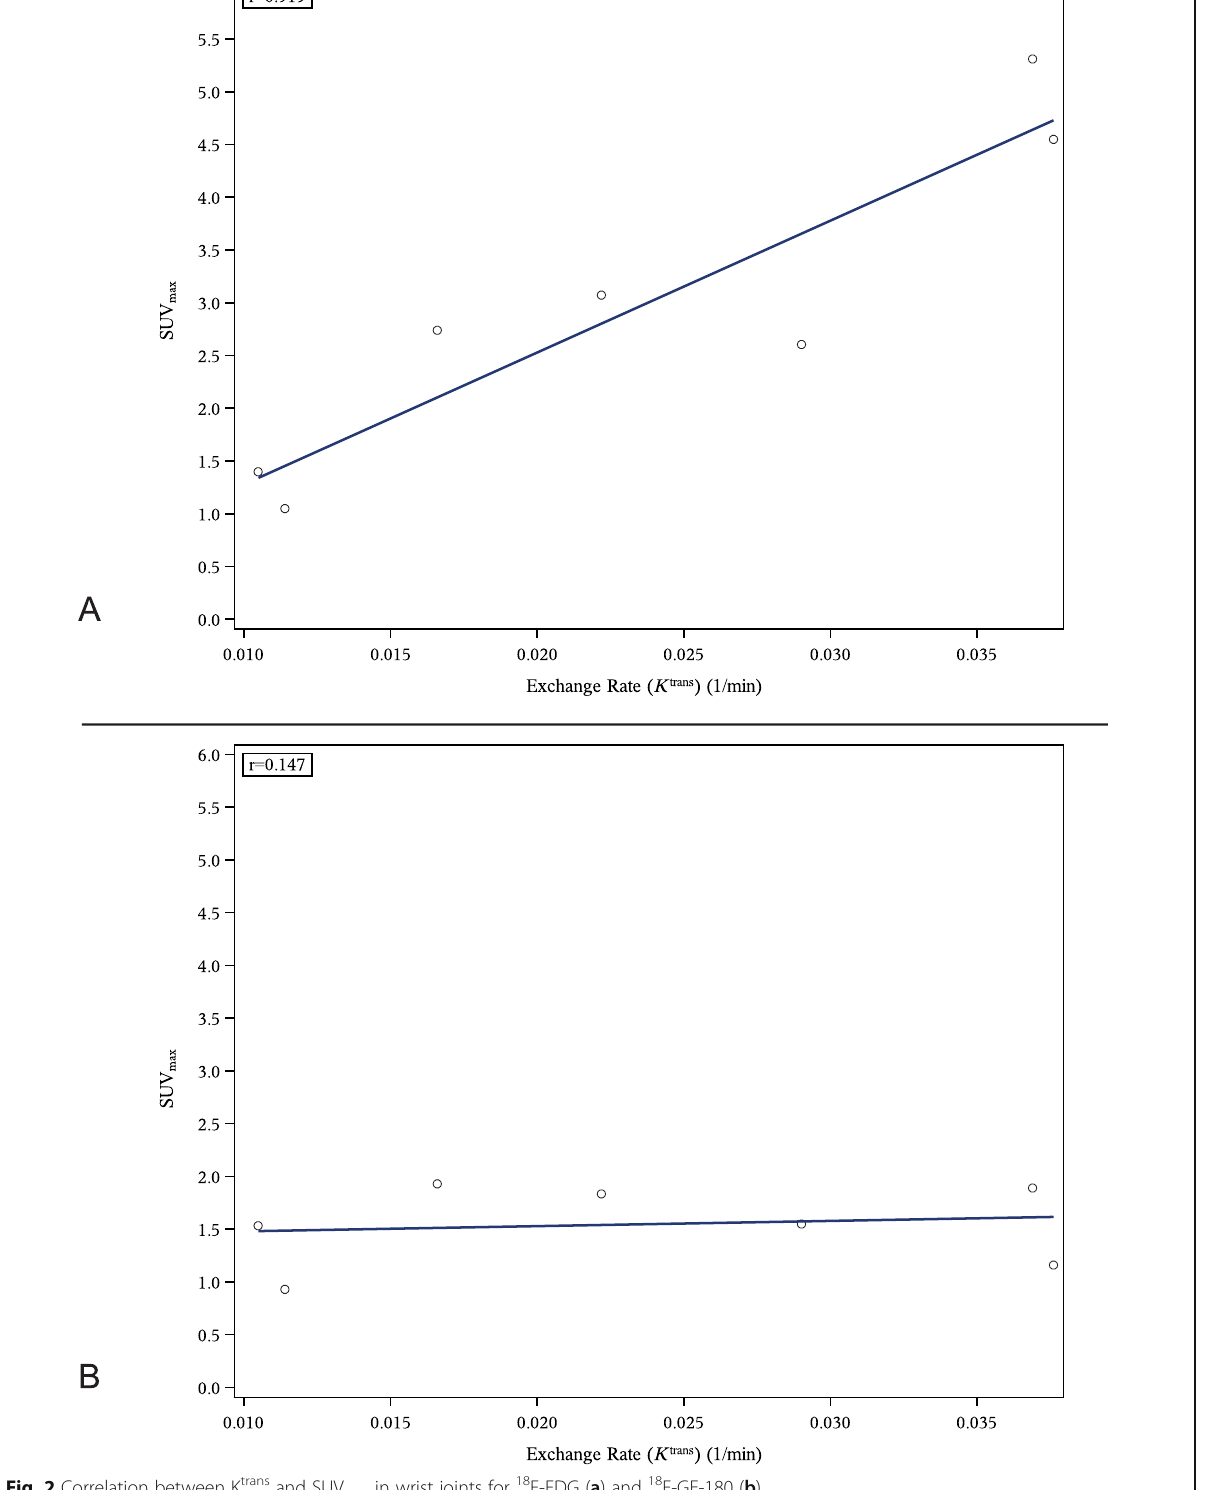
Fig. 2 Correlation between K trans and SUV max in wrist joints for 18 F-FDG ( a ) and 18 F-GE-180 ( b